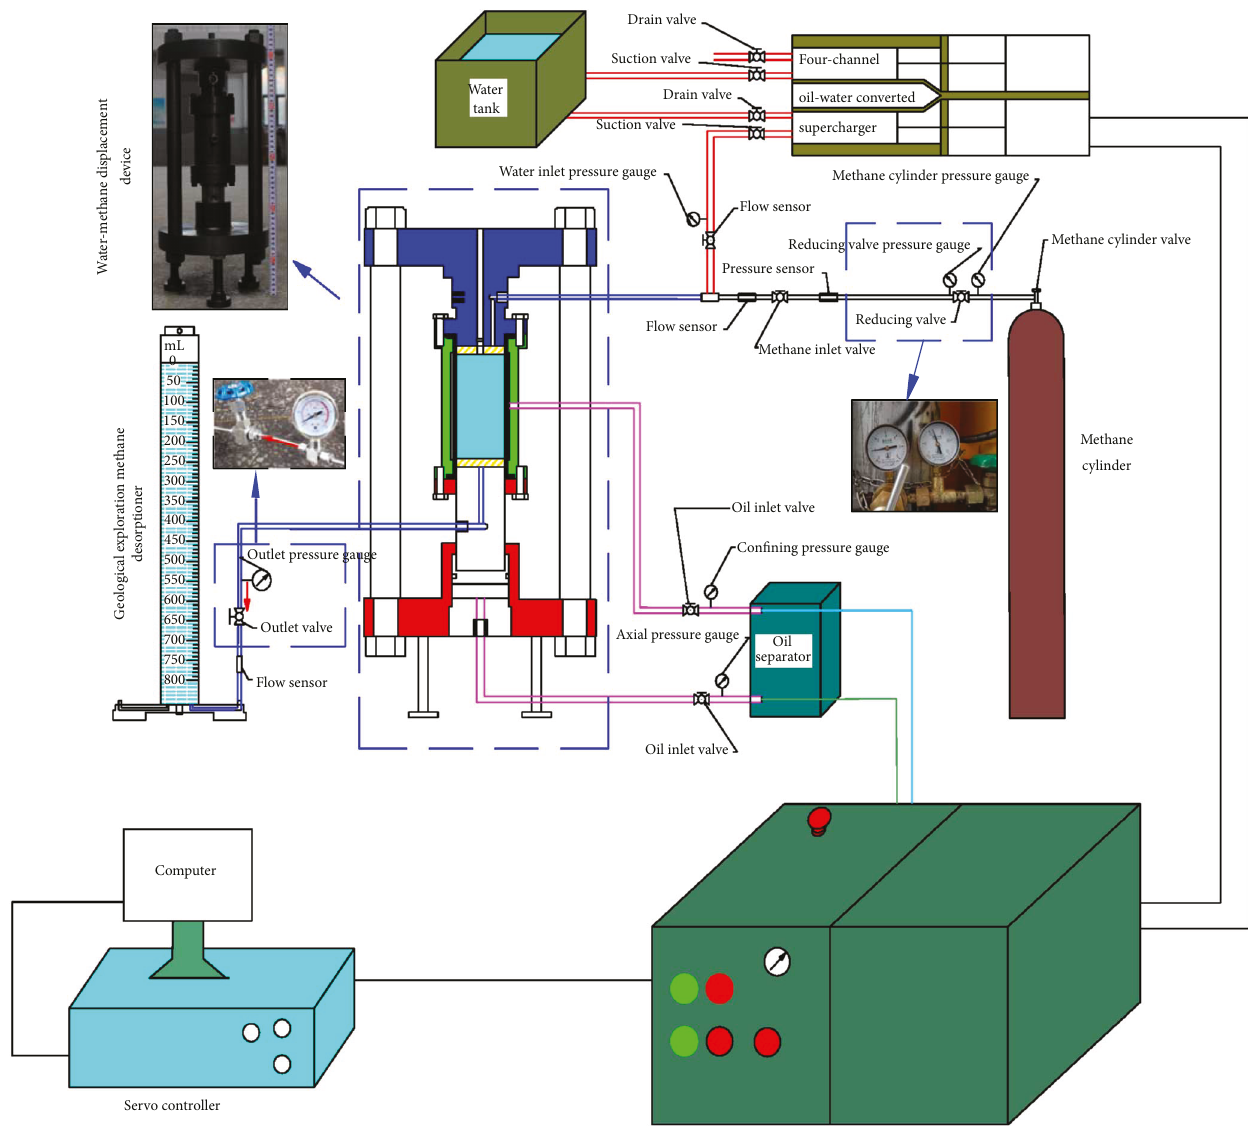
Figure 4: Experimental system of methane displacement by